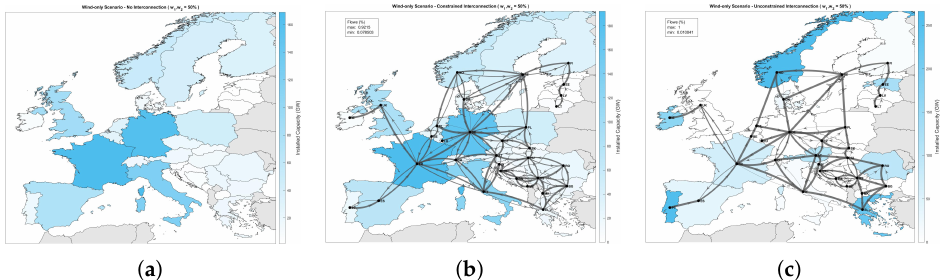
Figure 7. Optimal capacity allocation and cross-border energy flows for the case of wind power portfolios: ( a ) no interconnection, ( b ) constrained interconnection and ( c ) unconstrained interconnec- tion scenario.